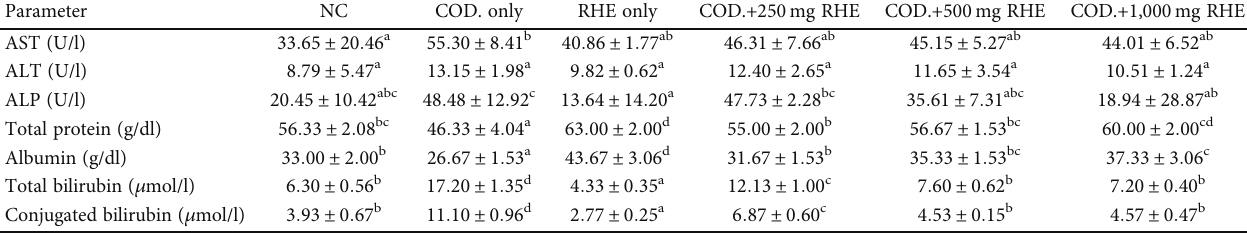
Groups with di ff erent superscripts are signi fi cantly di ff erent at p < 0 : 05 , while groups with same superscripts are not. Key: NC = normal control; COD. only = administered 10mg codeine/kg b.w of rat; RHE only = administered 500mg of rice husk extract/kg b.w of rats; COD.+250mg RHE = administered 10 mg